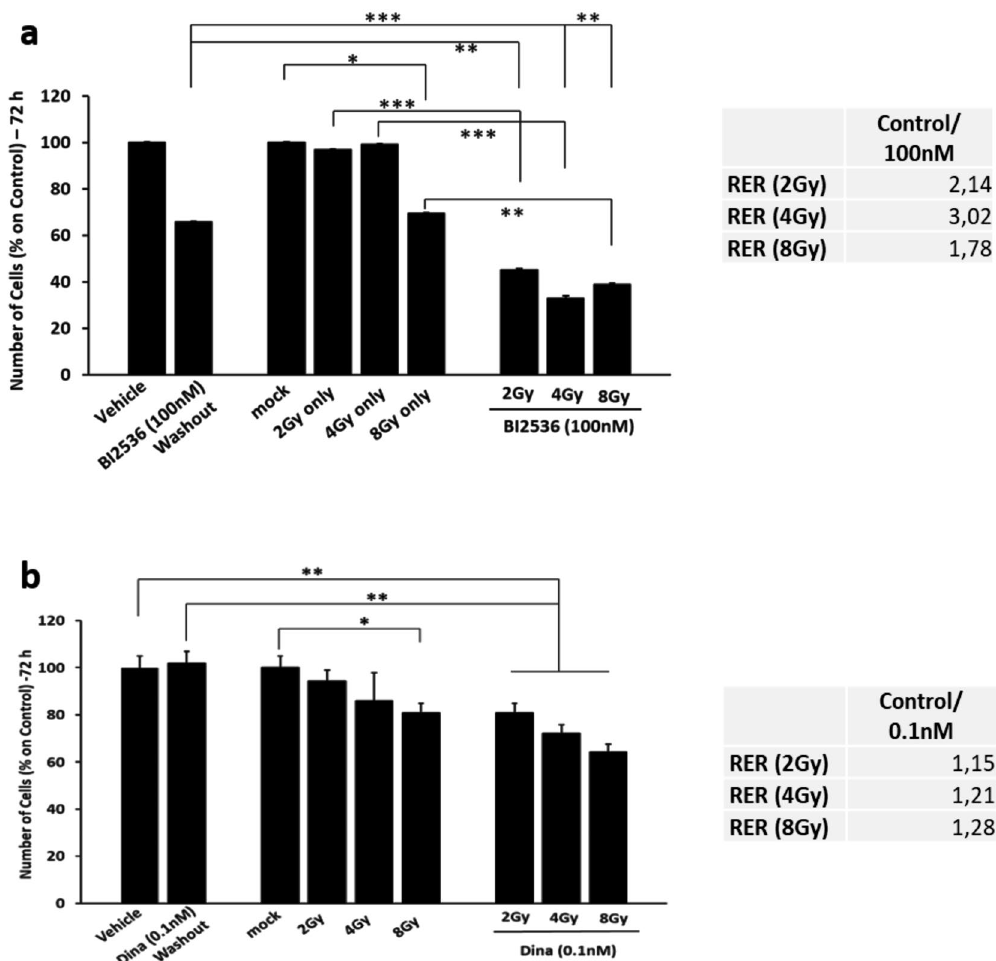
Figure 5. Pre-treating PC3 cells with PLK1 and CDK inhibitors for 24 h prior to radiation, enhances in cell death. ( a ) Cell counts of PC3 primed to radiation (Xrad) with the PLK1 inhibitor BI2536 (100 nM) for 24 h. Counts were taken at 72 h from the radiation (2, 4 and 8 Gy). Radiation Enhancement Ratio (RER) is shown for BI2536 (100 nM) and Radiation (2, 4 and 8 Gy) and calculated out of 3 independent experiments. ( b )